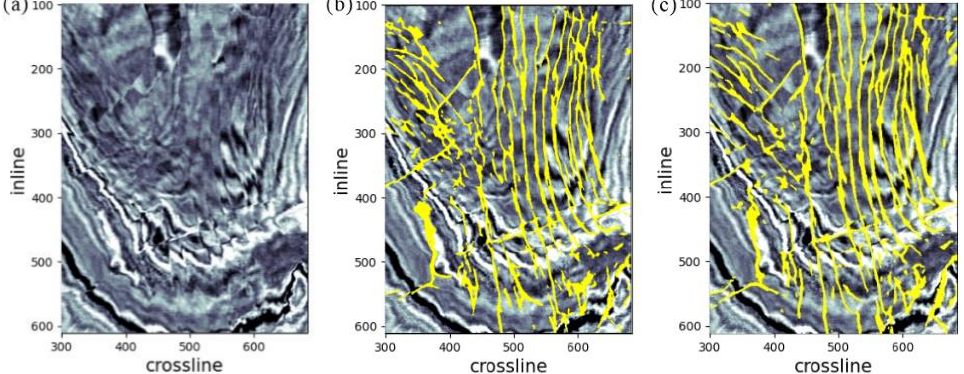
Figure 15. The 1437 ms time slice fault prediction results. ( a ) Time slice; ( b ) prediction results of UNet model; ( c ) prediction results of SE-UNet model.